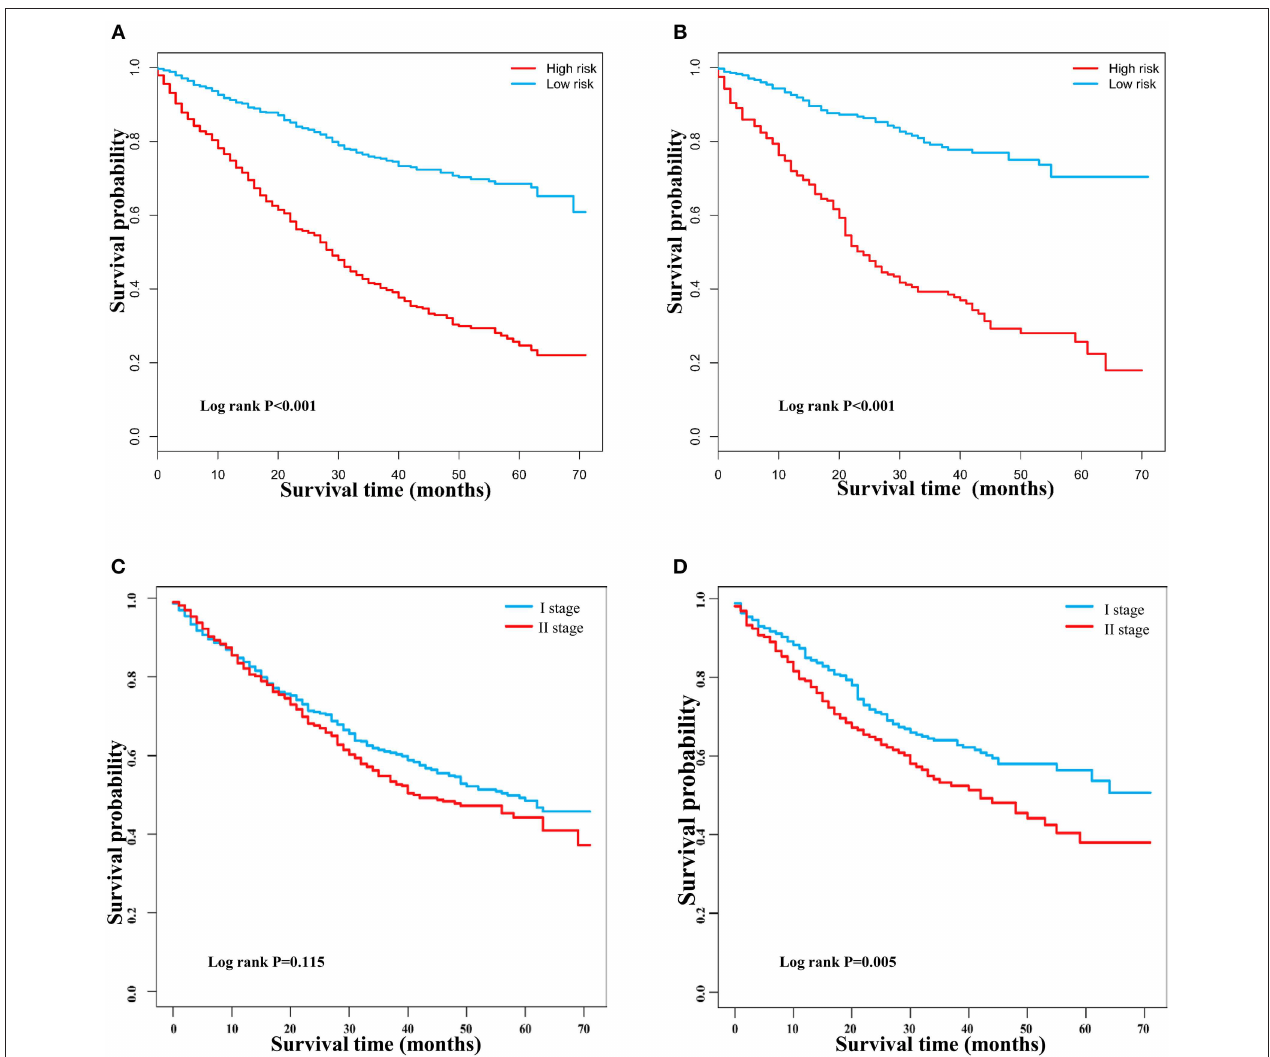
FIGURE 7 | Kaplan–Meier survival curves of patients with early hepatocellular carcinoma stratified by the nomogram and TNM staging. (A) Training group based on the nomogram. (B) Validation group based on the nomogram. (C) Training group based on TNM staging. (D) Validation group based on TNM staging.